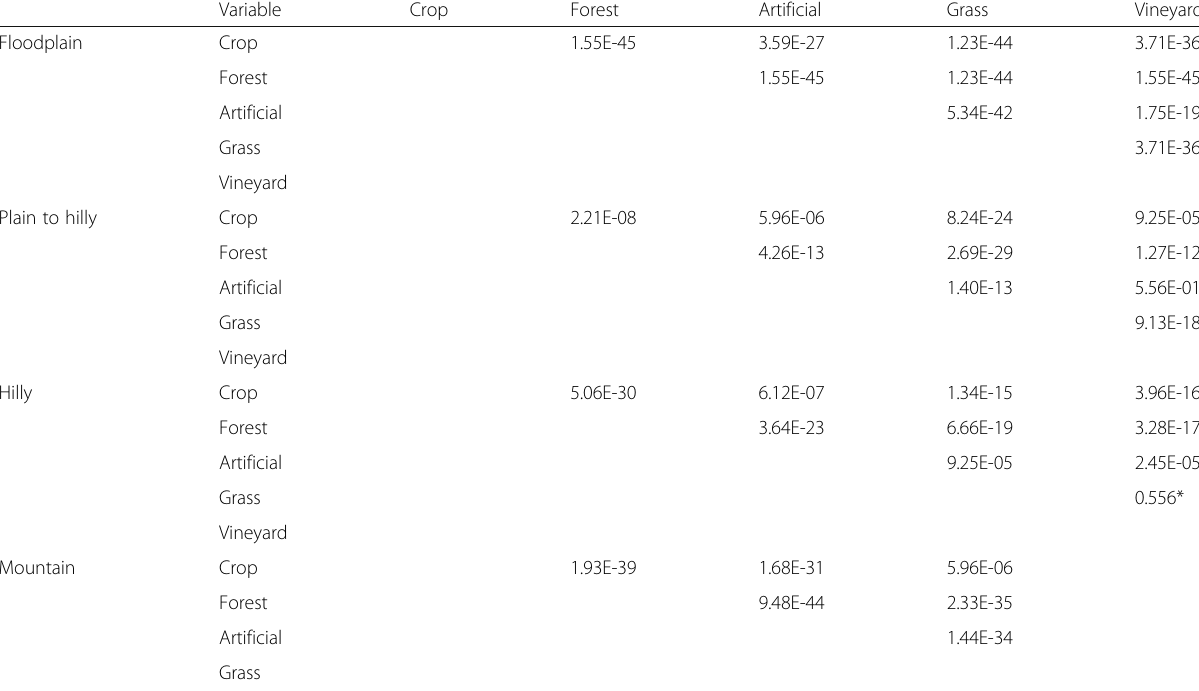
Table 2 The significance level of two-sample Kolmogorov-Smirnov tests of pairwise differences in slope between land covers within topographic